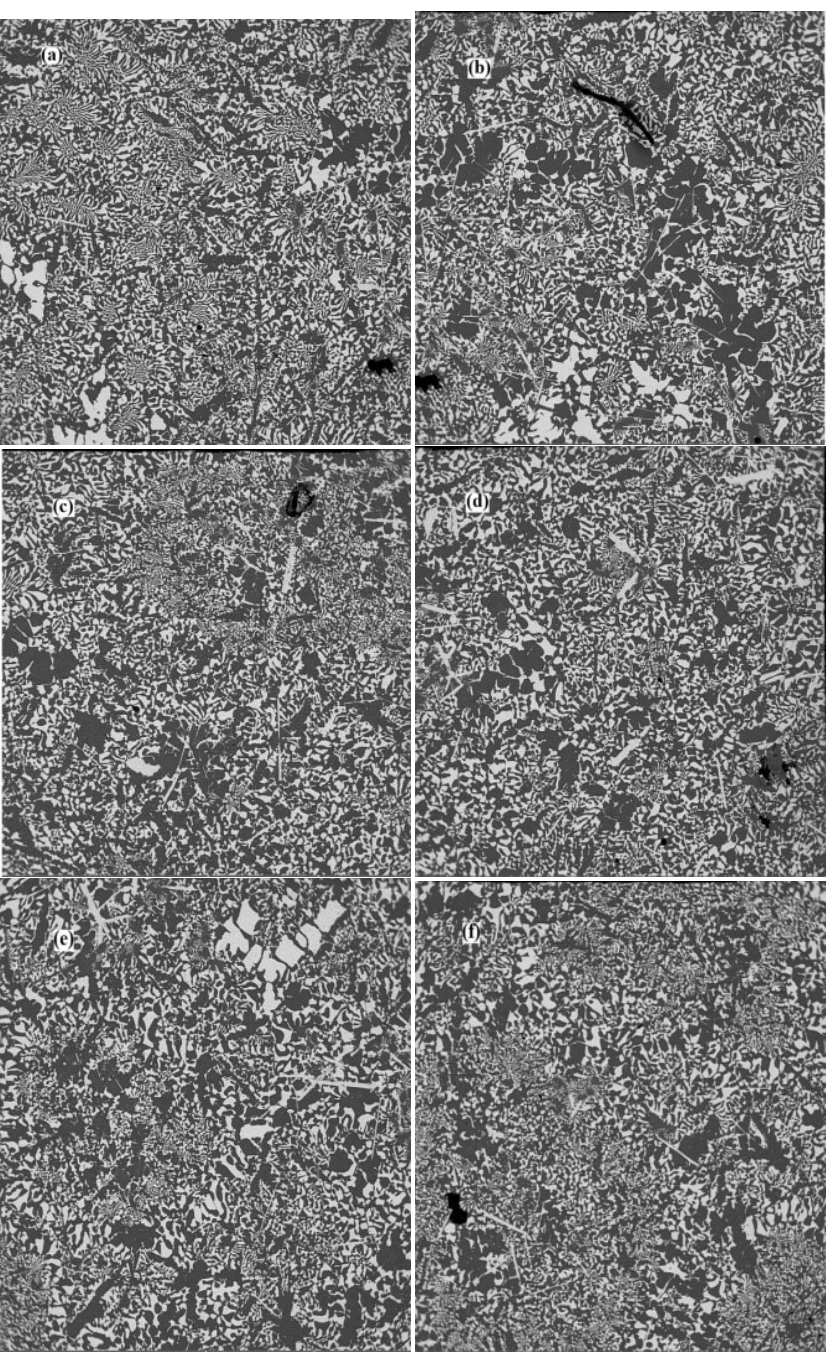
Figure 3: The typical FESEM microstructures of the Al-Al 2 Cu FGM cylindrical shell at different zones which are (a) 0-2 mm, (b) 2-4 mm, (c) 4-6 mm, (d) 6-8 mm, (e) 8-10 mm, (f) 10-12 mm, from the inner surface along the radial